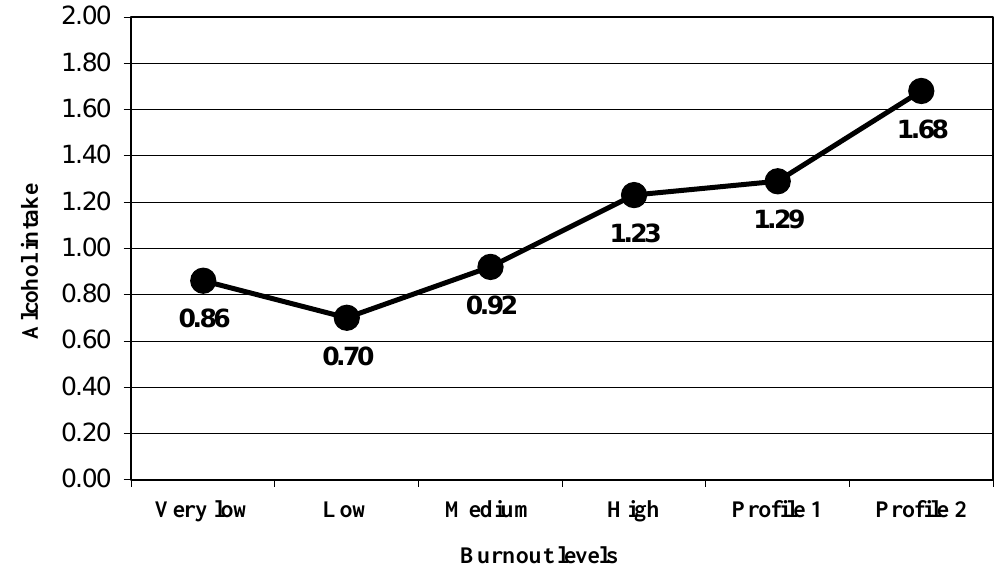
Figure 2. Mean in the psychosomatic disorders variable for the groups of burnout levels. For the variable alcohol intake associated with occupational problems, the results showed significant differences between the participants included in the medium levels of the burnout group (M = 0.92) and participants in Profile 2 (M = 1.68; p = 0.023), and between the participants included in the low levels of the burnout group (M = 0.70) and participants in Profile 2 ( p = 0.005). The difference